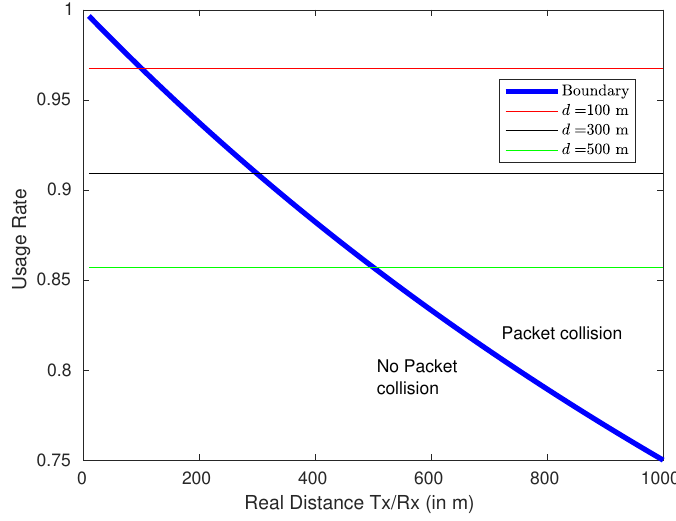
Figure 6. Network usage rate for T frame = 2 s.